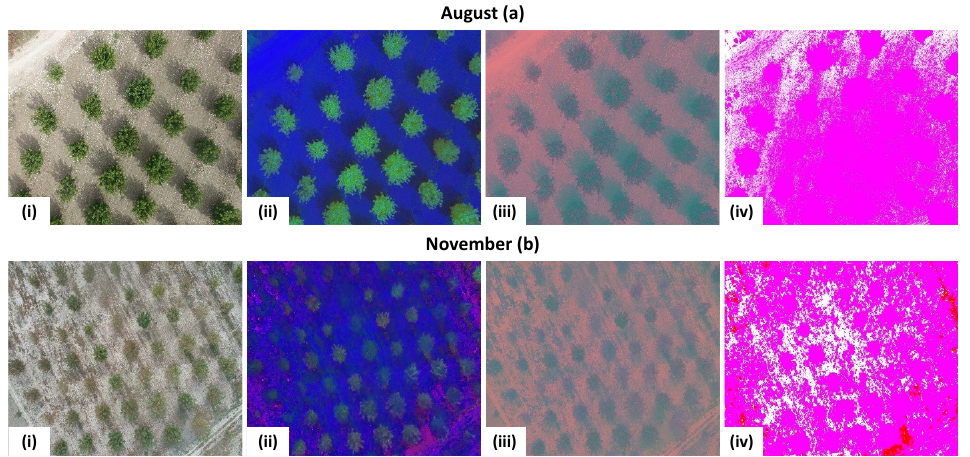
Figure 4. Color space representation and transformation: RGB [ a ( i ) and b ( i )]; HSV [ a ( ii ) and b ( ii )]; YCbCr [ a ( iii ) and b ( iii )]; and L*a*b* [ a ( iv ) and b ( iv )]. Second, the appropriate color range was selected. The transformation of the orchard into the HSV color space was dominated by two colors (i.e., green and blue). The orchard trees were depicted in green color, while the areas of low interest (i.e., the rest of the agri- field) were displayed in blue color. The areas of high interest were isolated from the rest of the orchard (Figure 5a(i),b(i)). This procedure was performed on a function that receives an RGB image as input, converts the image to HSV, and isolates the areas of interest. The final steps of the image processing include: (i) noise removal (Figure 5a(ii),b(ii)); and (ii) transformation of the mosaic into a grayscale (Figure 5a(iii),b(iii)). Figure 5c presents the mosaic of the agricultural field used in this study following the image processing.